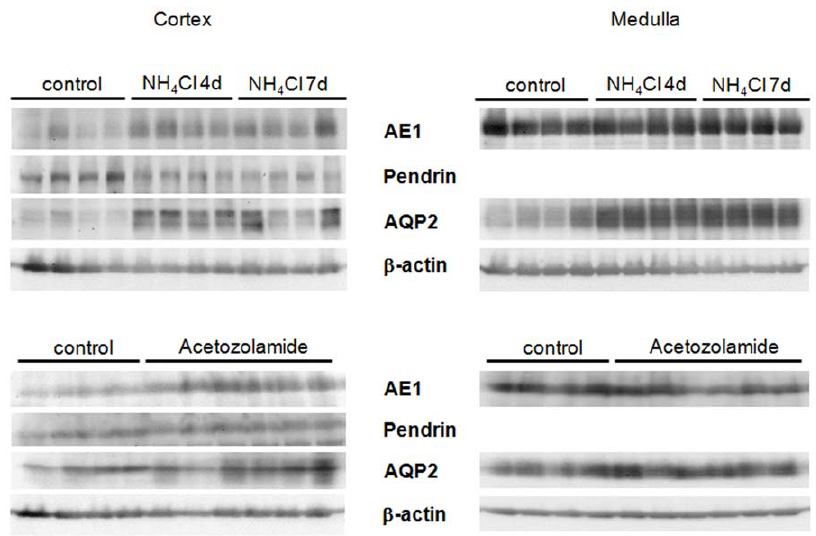
Figure 5. Regulated expression of AE1, pendrin, and AQP2 during different treatments. Immunoblotting of total membranes prepared from cortex and medulla demonstrated regulation of AE1, pendrin and AQP2 in the different treatment groups. N=4 animals/ group.